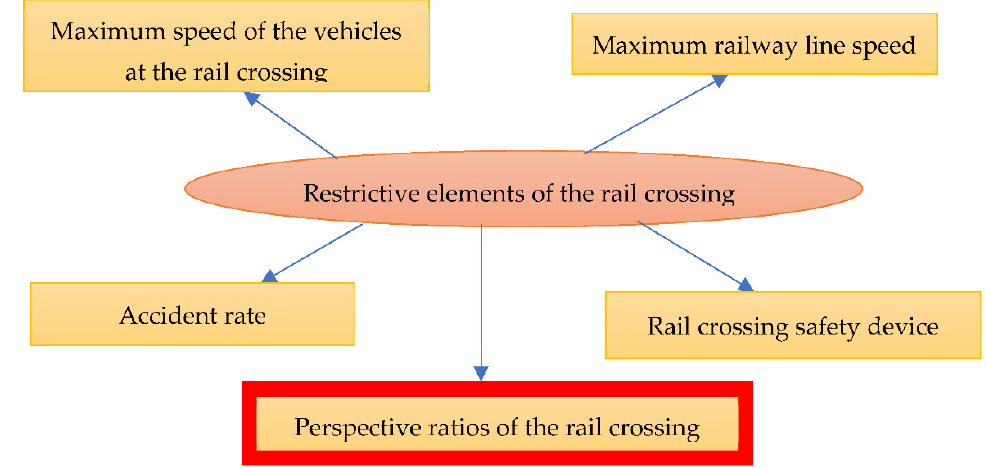
Figure 5. Restrictive elements of rail crossing